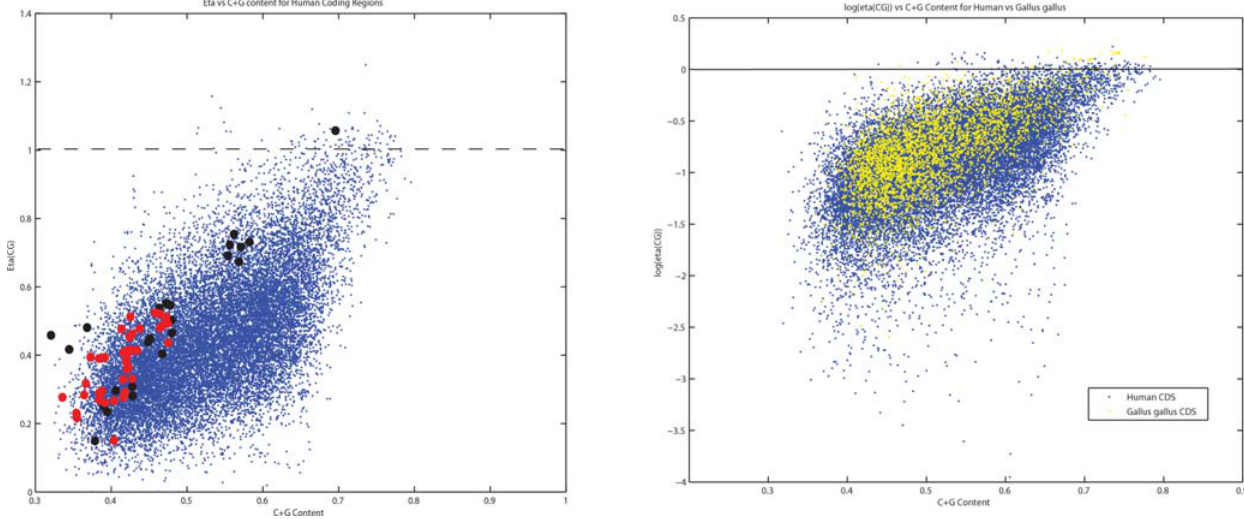
Figure 2. Comparison of CpG suppression in host and viral genomes. Left: CpG odds ratio versus C + G content for human genes in blue. Superimposed on top of these genes are the human RNA viruses from Figure 1, in the same color scheme: Human ssRNA + (black) and Human ssRNA 2 (red). Right: Natural logarithm of the CpG odds ratio (log( g )) versus C + G content for human (blue) and chicken (yellow) (Gallus gallus) coding genes of at least 500 bases. A value of log( g ) close to 0 (marked in the figure with a dashed line), indicates that the observed number of CpGs is similar to the expected. CpGs preassures are stronger in human than in birds.